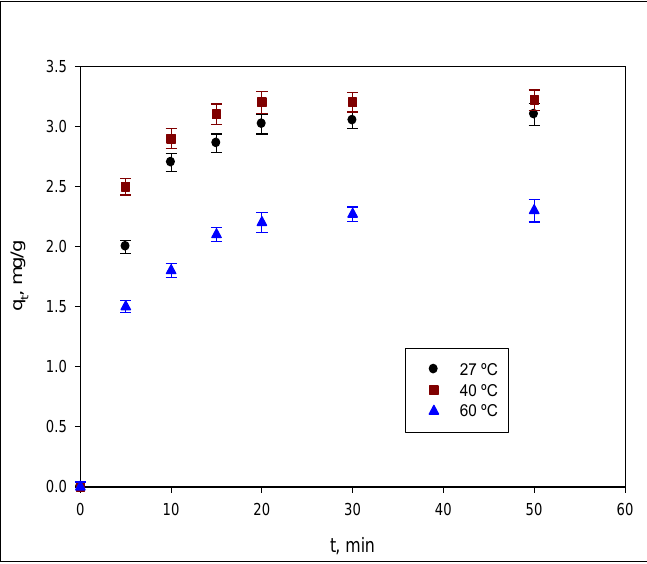
Figure 1: Experimental adsorption capacities in function of contact time at different temperatures.